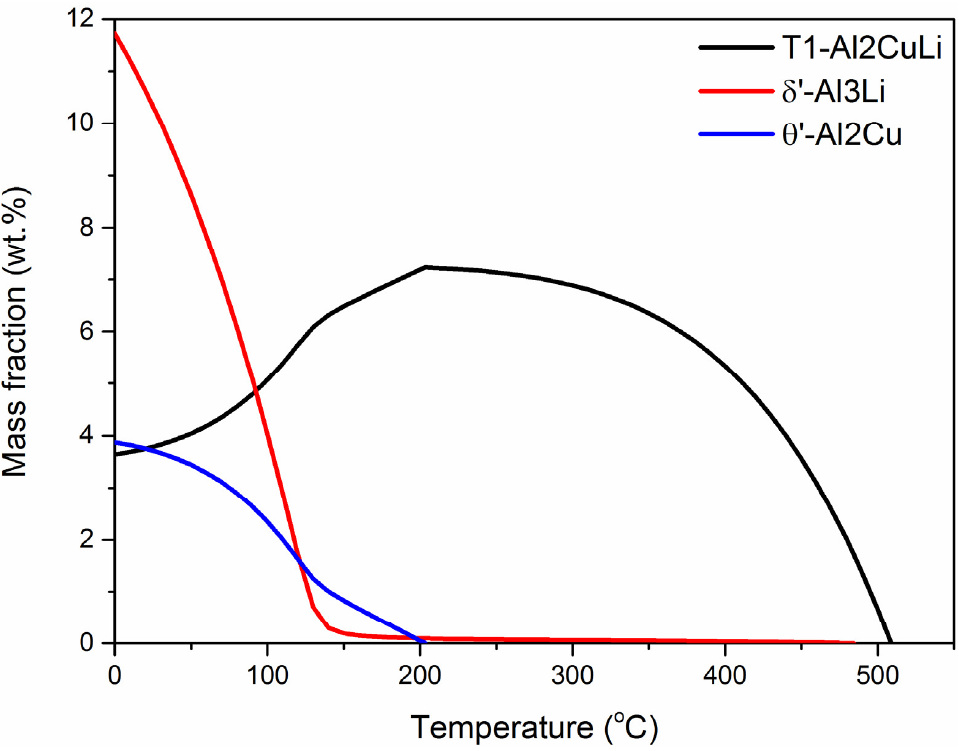
Figure 8. Calculated T1-Al2CuLi, δ ’-Al3Li and θ ’-Al2Cu phases.